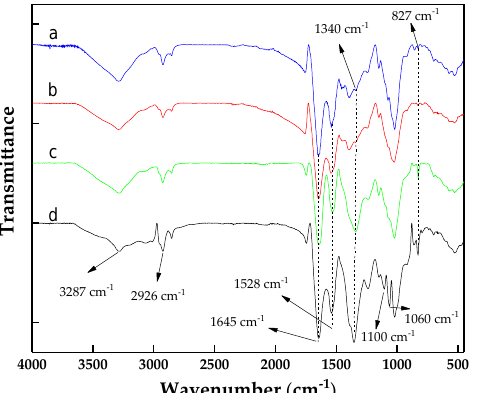
Figure 6. The FT-IR spectra of C. vulgaris and the C. vulgaris flocs: ( a ) C. vulgaris , ( b ) C. vulgaris flocs formed by chitosan, ( c ) C. vulgaris flocs formed by walnut protein, and ( d ) C. vulgaris flocs formed by chitosan and walnut protein.